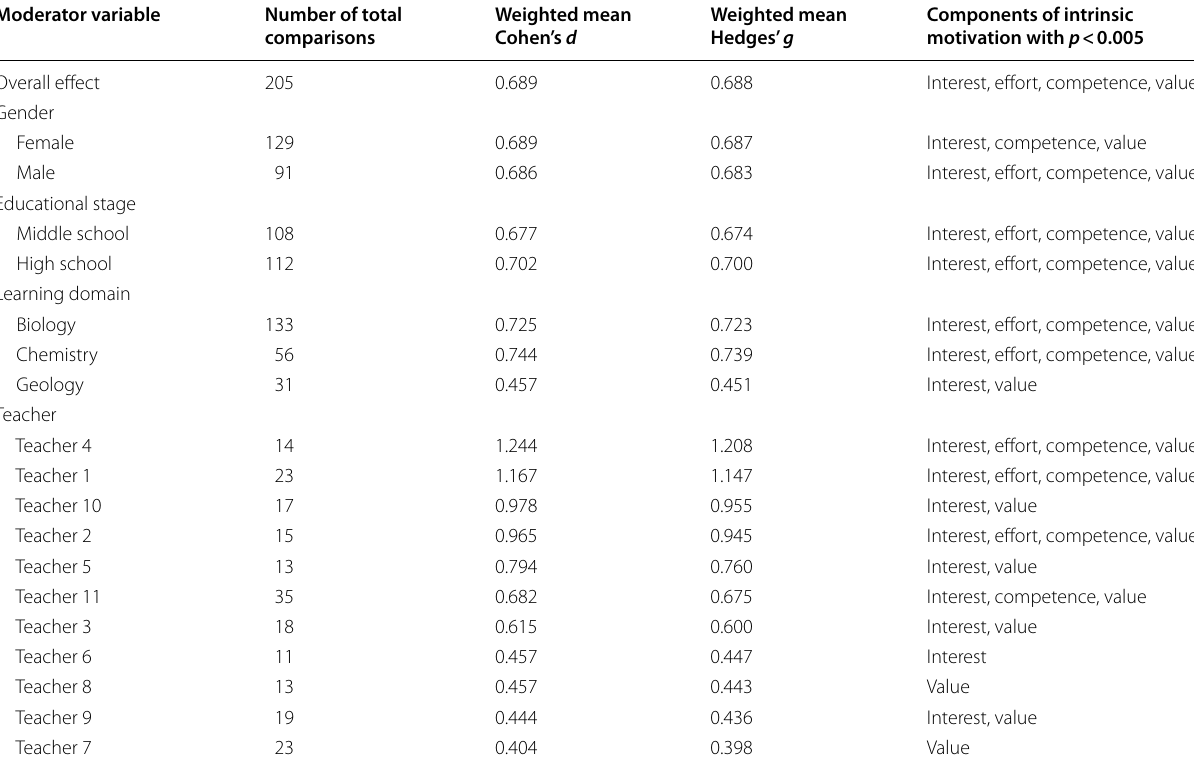
Table 7 Effect sizes for individual characteristics in the EG (data from the first experimental